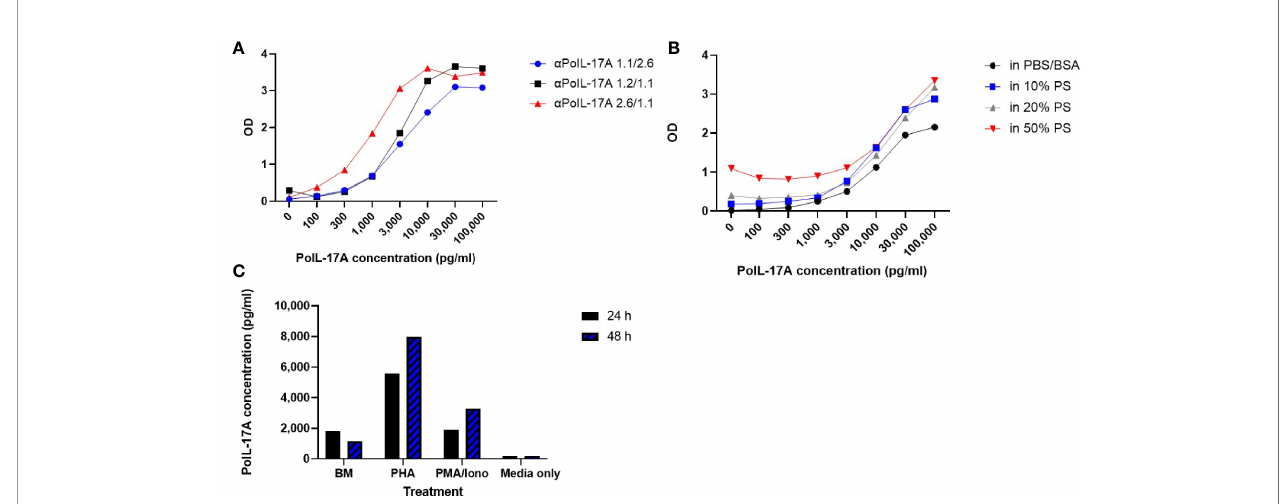
FIGURE 3 | Sandwich ELISA Assay and Quantitation of IL-17A. (A) Comparison of IL-17A standard curves generated with 3 sets of a PoIL-17A mAb pairs as capture vs detection respectively: a PoIL-17A-1.1/2.6; 1.2/1.1; and 2.6/1.1; (B) Detection of rPoIL-17A diluted in PBS-BSA or in pig serum using the anti-PoIL-17A- 1.1/2.6 mAb Sandwich assay. The assays were repeated >5 times; (C) Detection of native porcine IL-17A in PBMC supernatants using the anti-PoIL-17A-1.1/2.6 mAb assay. Supernatants were harvested from cells cultured for 24 or 48 hours (24 h/48 h) in medium (BM), PHA or PMA/Iono stimulated cells as described in M&M. This assay was conducted >3 times evidencing repeatability.